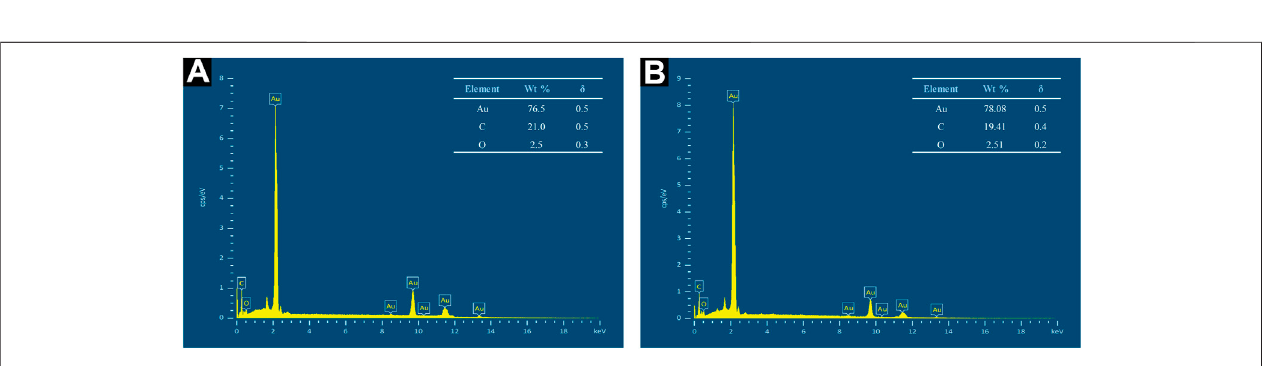
FIGURE 10 | EDX spectra of (A) AuNPs@pH6 and (B) AuNPs@pH10